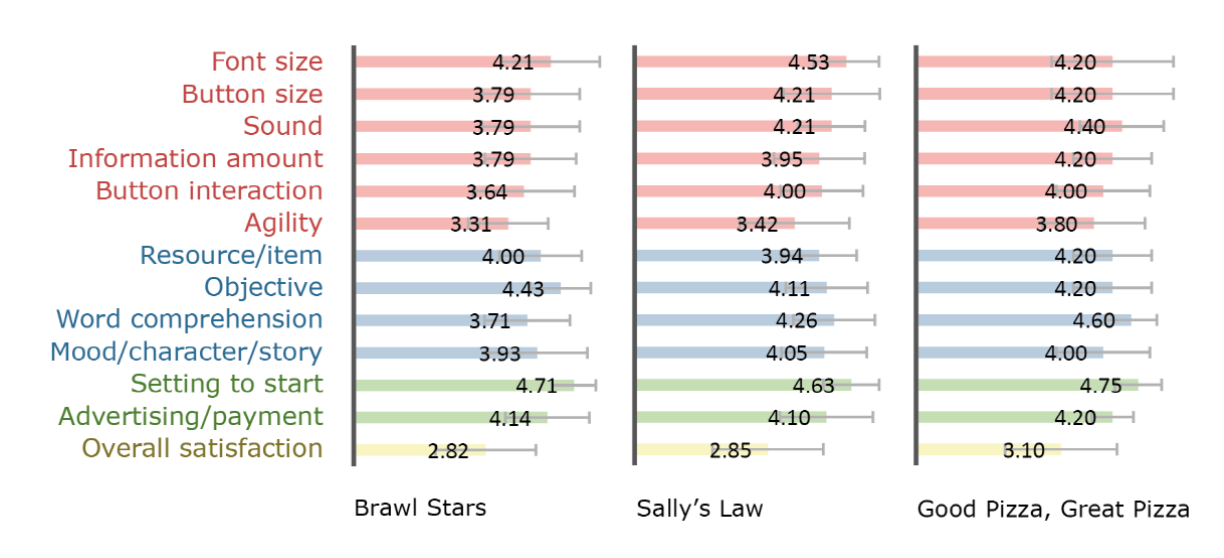
Figure 3. Satisfaction levels in games played by the middle-aged group.